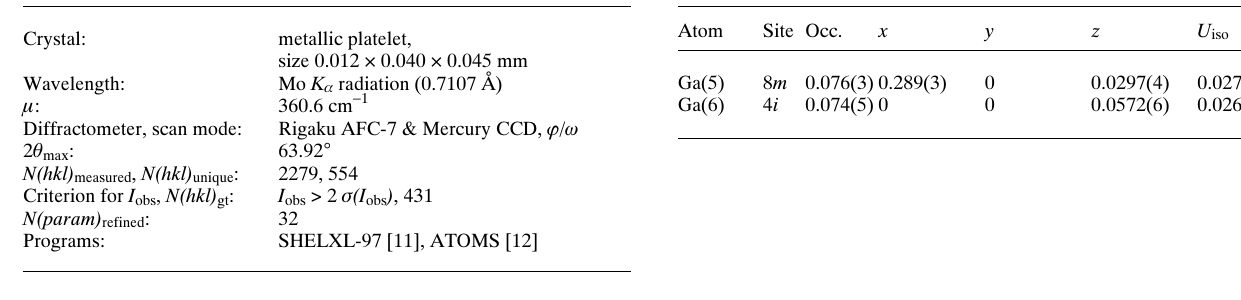
Table 1. Data collection and